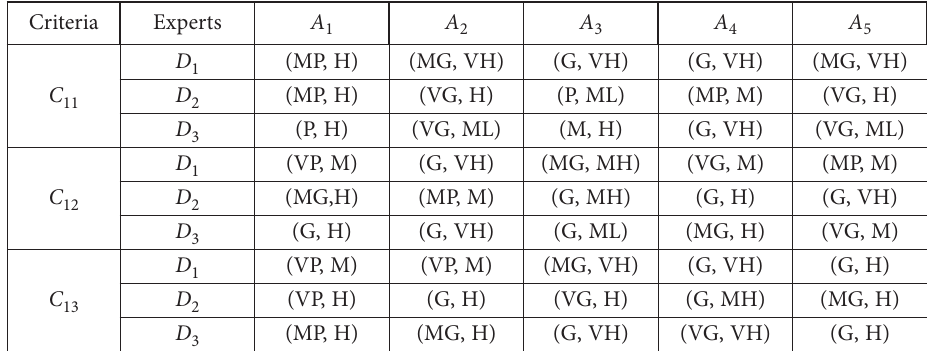
Table 6. Rating of suppliers with respect to criteria assessed by decision makers